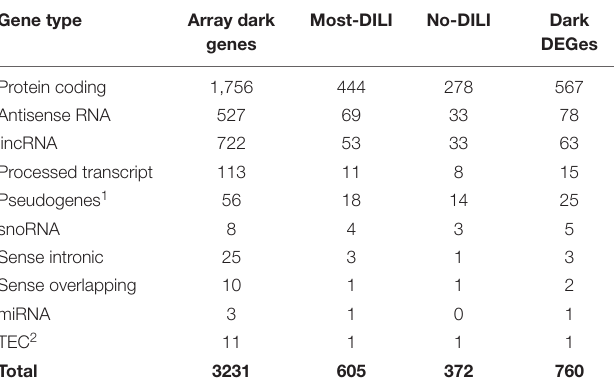
TABLE 2 | Classification of genes without GO BP annotation and absent on Reactome, MSigDB, OmniPath, and Pathway Commons databases (dark genes) modulated by compounds from most-DILI and no-DILI